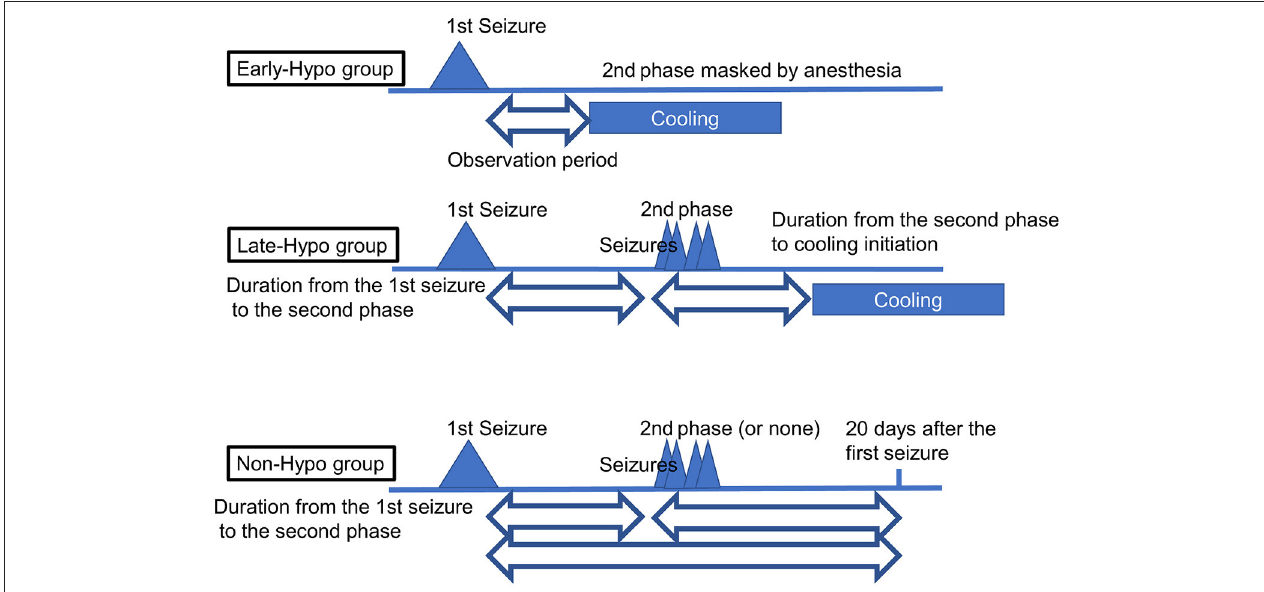
FIGURE 1 | The outlines regarding the observation periods in each treatment group for truncal instability and titubation. In the Early-Hypo group, the observation period for truncal instability and titubation is the period from the 1st seizure to cooling initiation. In the Late-Hypo group, the observation periods are the period from the 1st seizure to the 2nd phase and the period from the 2nd phase to cooling initiation. In the Non-Hypo group, the observation periods are the period from the 1st seizure to the 2nd phase and the period from the 2nd phase to 20 days after the first seizure in patients with the 2nd phase. The observation period is the period from the first seizure to 20 days after the first seizure in patients without the second phase. The observation periods do not include the first 6h following each